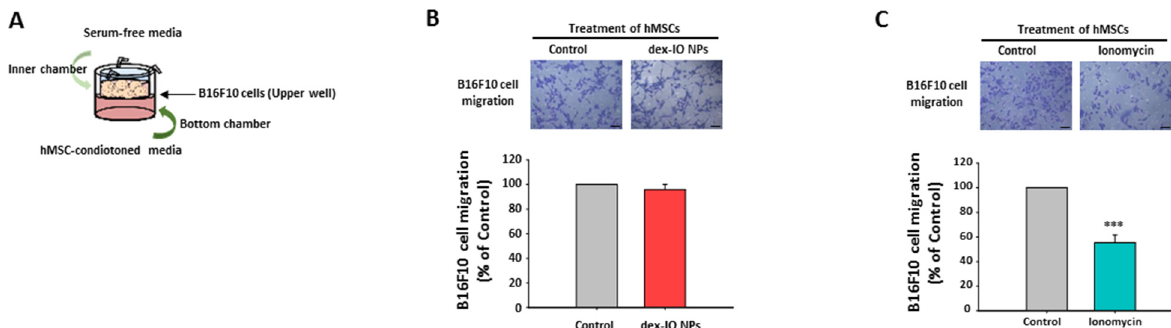
Figure 3. Effects of hMSC-conditioned media in the bottom chamber on B16F10 cell migration in the transwell migration assay. ( A ) Schematic illustration of the experimental procedure. hMSCs were first treated without (Control) or with dex-IO NPs for 1 h or ionomycin for 30 min followed by wash, and then conditioned media from hMSCs incubated for 24 h were collected and added to the bottom chambers. ( B , C ) Migration of B16F10 cells toward hMSC-conditioned media. Top panel: representative images of the migration of B16F10 cells by crystal violet staining. Bottom panel: quantification of the migration of B16F10 cells. Data are presented as the mean ± SEM of three independent experiments. *** p < 0.001 as compared with Control. Scale bar: 20 μ m.